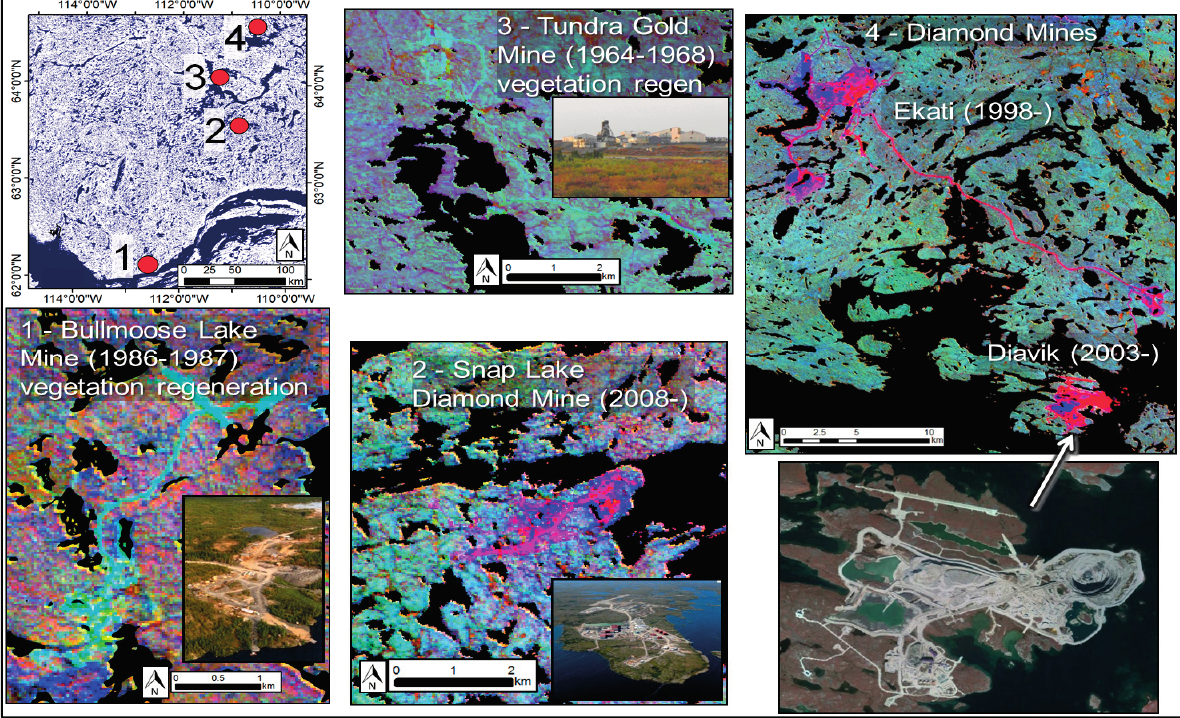
Figure 14. Examples of TC trend imagery north of Yellowknife showing abandoned mining sites with regeneration (teal) and the footprint of recently developed diamond mines (red and dark blue).